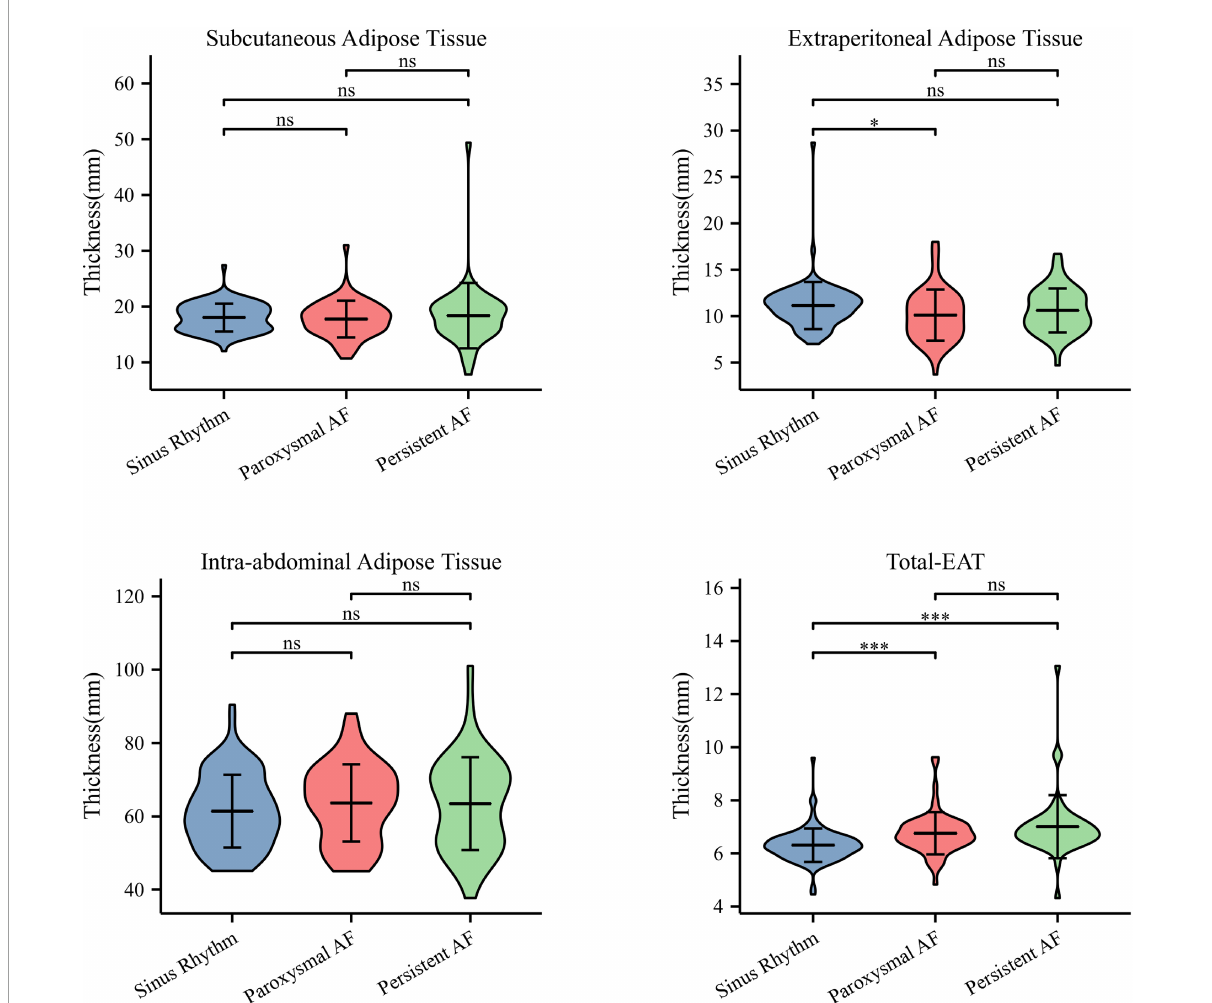
FIGURE1 Distribution characteristics of different adipose tissues in patients with AF. Only thickness of total-EAT was significantly increased in AF patients compared to that in patients with sinus rhythm. ∗ P < 0.05 and ∗∗∗ P < 0.001. AF, atrial fibrillation; EAT, epicardial adipose tissue; Total-EAT, mean EAT thickness surrounding the whole heart.